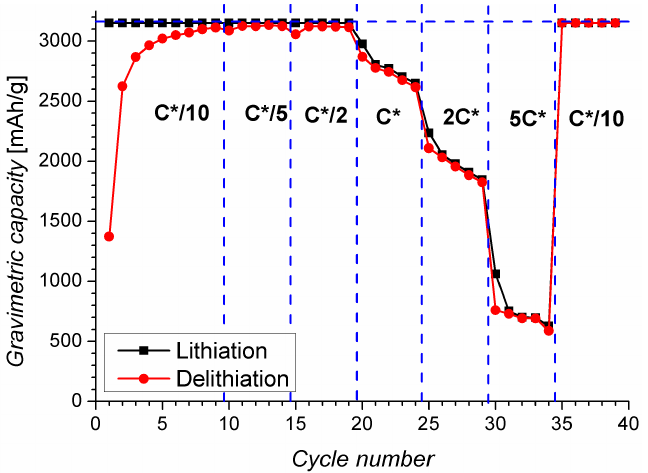
Figure 3. Curve of capacity vs. cycle number of the microwire anode cycled in the galvanostatic/potentiostatic mode at different C * rates during the galvanostatic steps. The C * rates have an asterisk * to indicate that they are only meaningful for galvanostatic